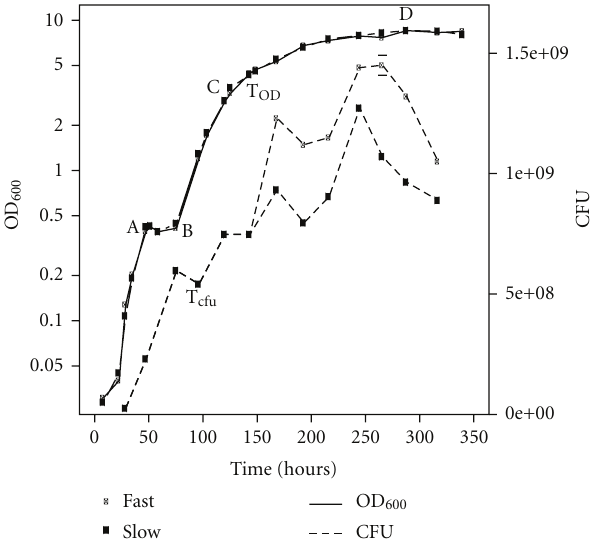
Figure 5: Mid-culture response of Halobacterium salinarum NRC- 1 to changes in shaking speed. Halobacterium salinarum NRC- 1 was grown at 100 rpm as described in Materials and Methods. Growth was tracked using both light scattering at 600 nm (solid lines) and by counting colony forming units using spread plate technique (dashed lines). OD 600 is reported against the left y -axis in logarithmic scale and CFU is reported against the right y -axis in linear scale. Half of the sample set were transferred to 150 rpm at ∼ 150 h. 100 rpm shaken cultures are shown as open circles and 150 rpm shaken cultures are shown as closed circles. Points A, B, C, and D refer to panels in Figure 6 in which the phenotype of the cultures are shown for the selected points. Error bars for CFU counts are included as + / − one standard deviation of 24 of 34 triplicate cultures. Error for time points without error bars were too small to display. Points marked with T indicated the points at which cultures were transferred from the slow shaking incubator to the fast shaking